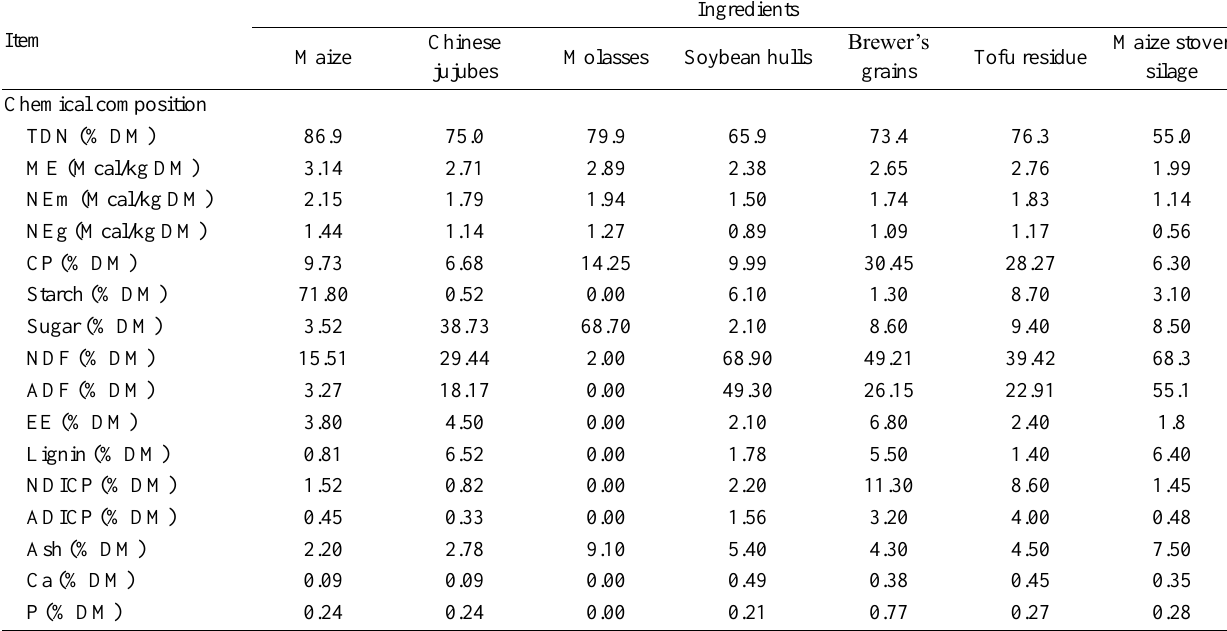
Ingredients Chinese Maize Molasses Soybean hulls jujubes